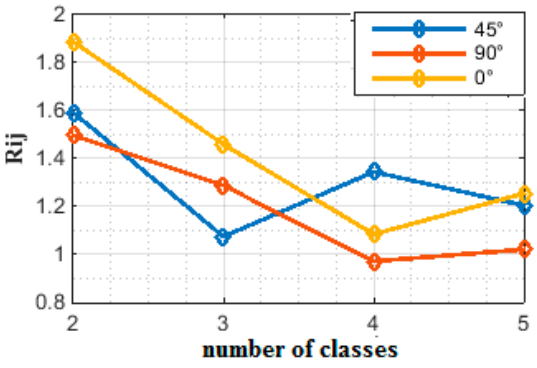
Figure 11. Determination of the optimal number of classes by the Davies and Bouldin criterion.